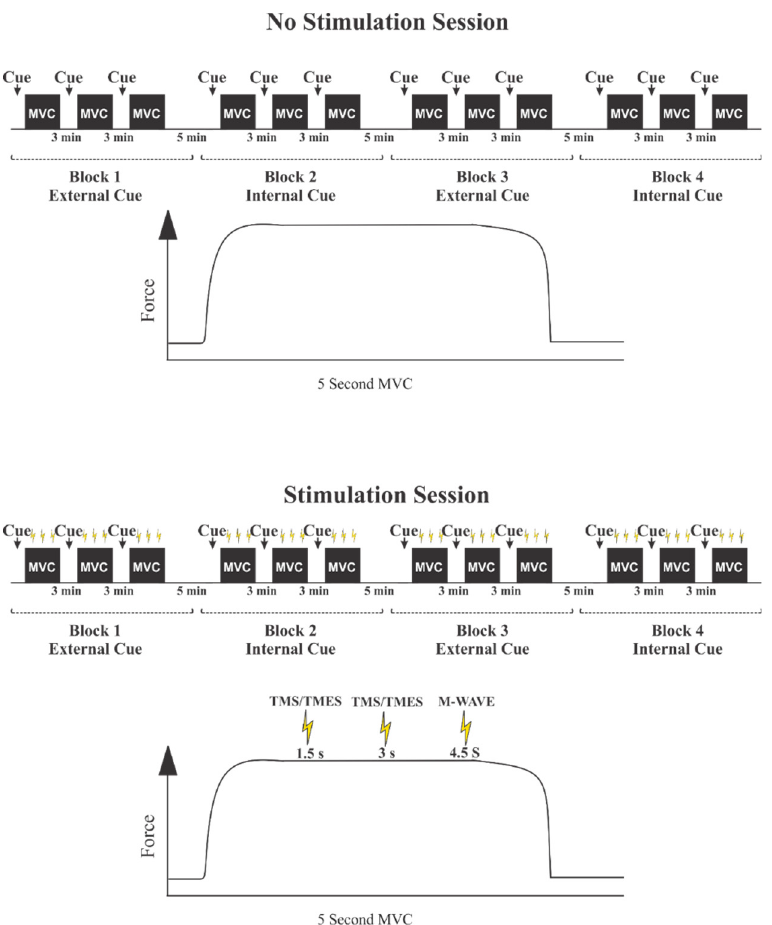
Figure 2. Experimental protocol. Each participant completed two experimental sessions (no stimulation session above, stimulation session below) which were randomized. Within each session, participants completed two blocks of three externally cued condition and two blocks of internally cued condition which were also randomized. Maximal voluntary contractions (MVC) were held for 5 s, beginning and ending at 2 and 7 s respectively, and during the stimulation session a transcranial magnetic stimulation (TMS) and transmastoid electrical stimulation (TMES) pulse was randomly delivered at 1.5 and 3.0 s marks with an M-Wave delivered each time at the 4.5 s mark. The traces underneath the sequence blocks represents the timing of the no-stimulation / stimulation during a 5 s MVC